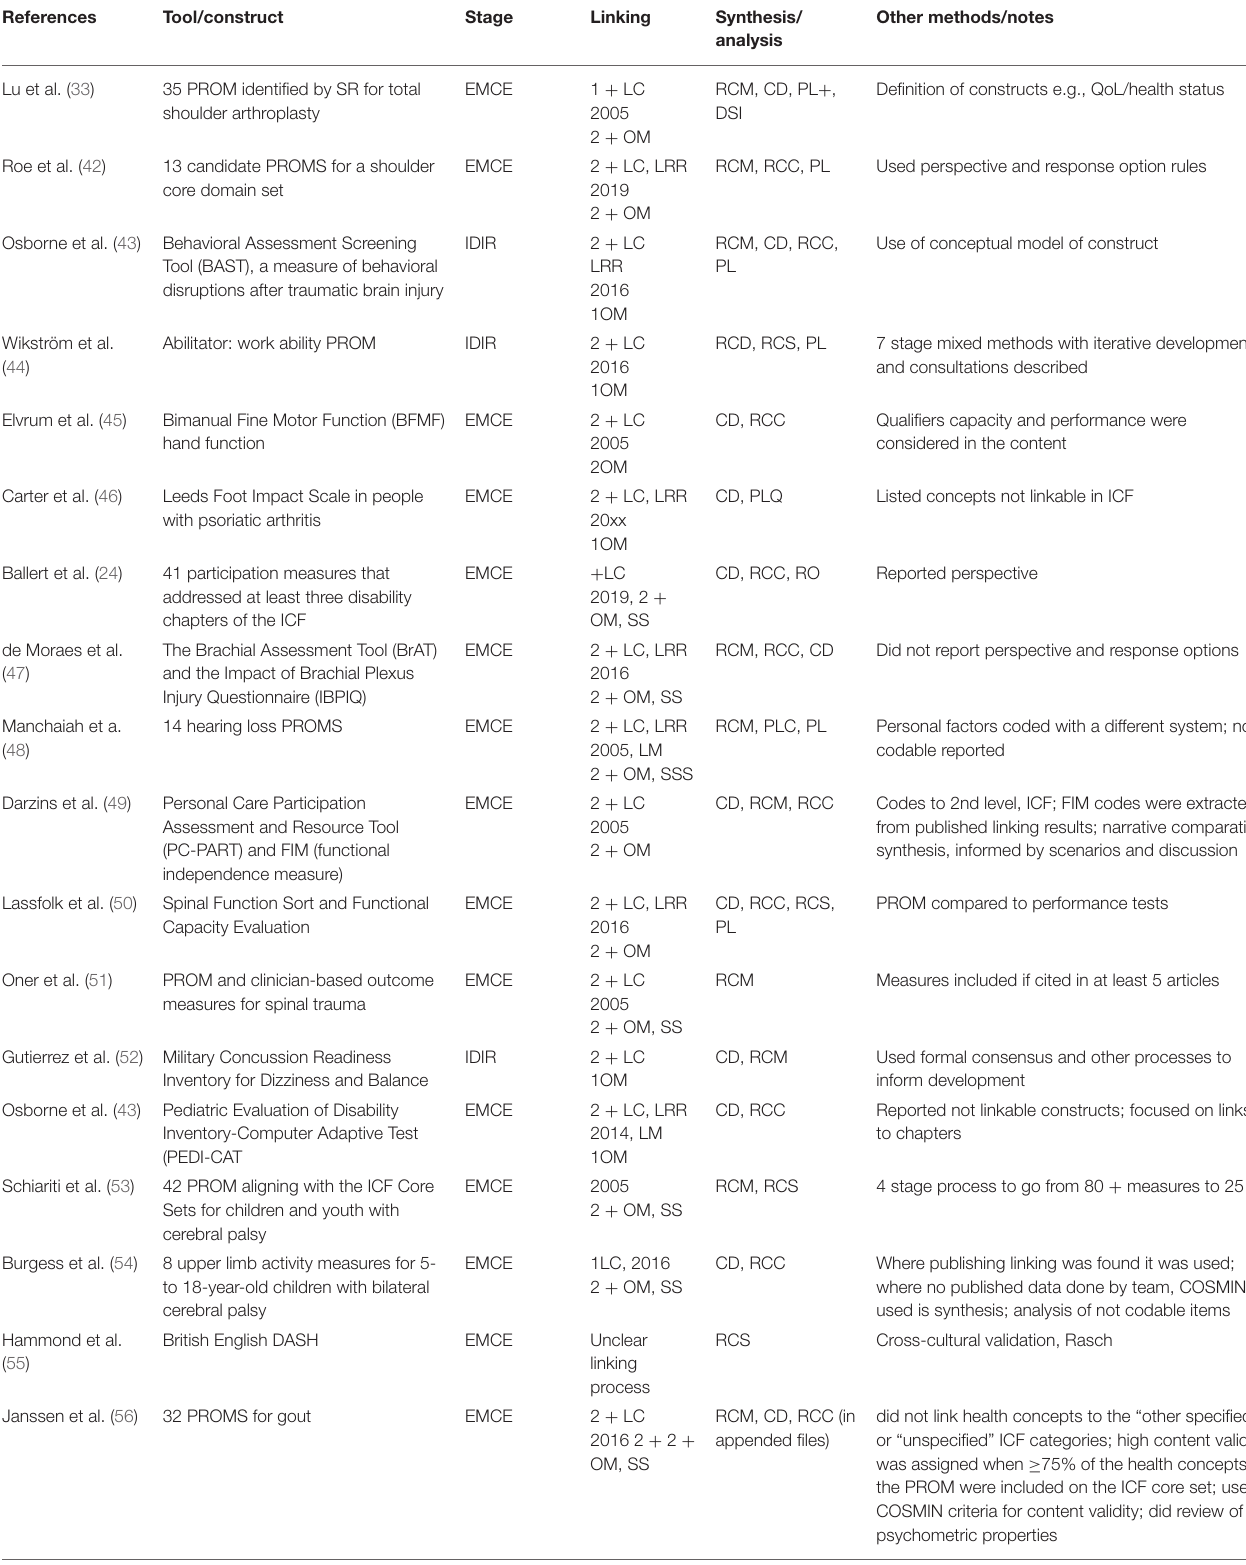
TABLE 4 | Recent use of ICF linking in content